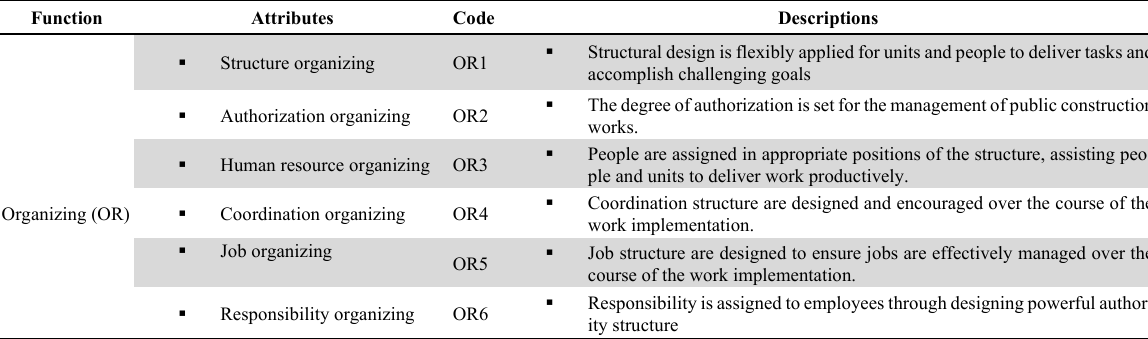
Attributes of organizing